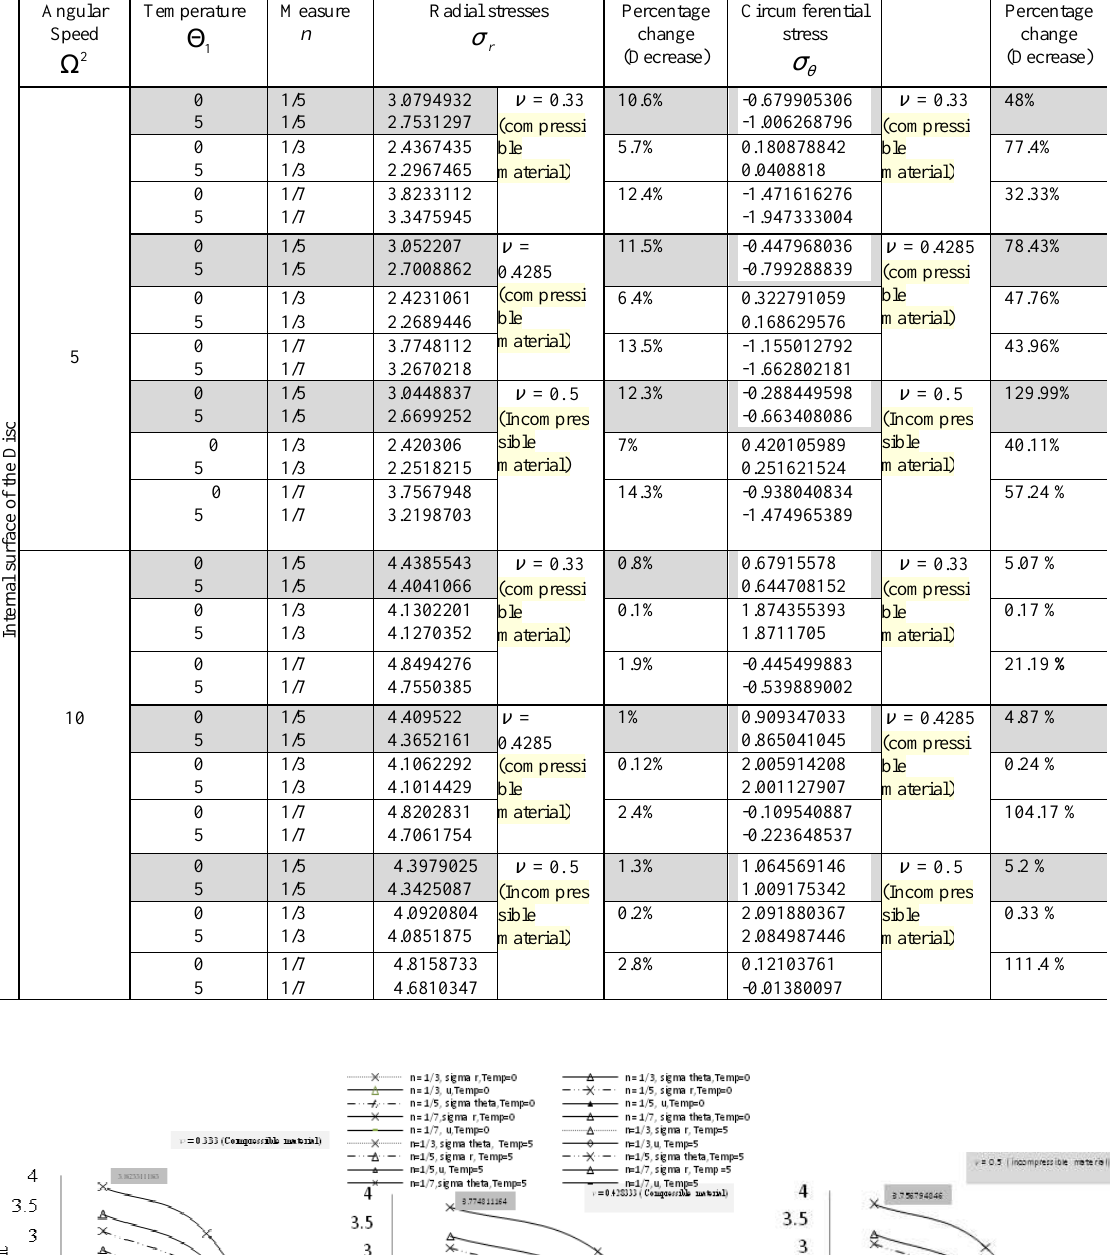
Table 1. Parentage change stresses for initial yielding and fully plastic state